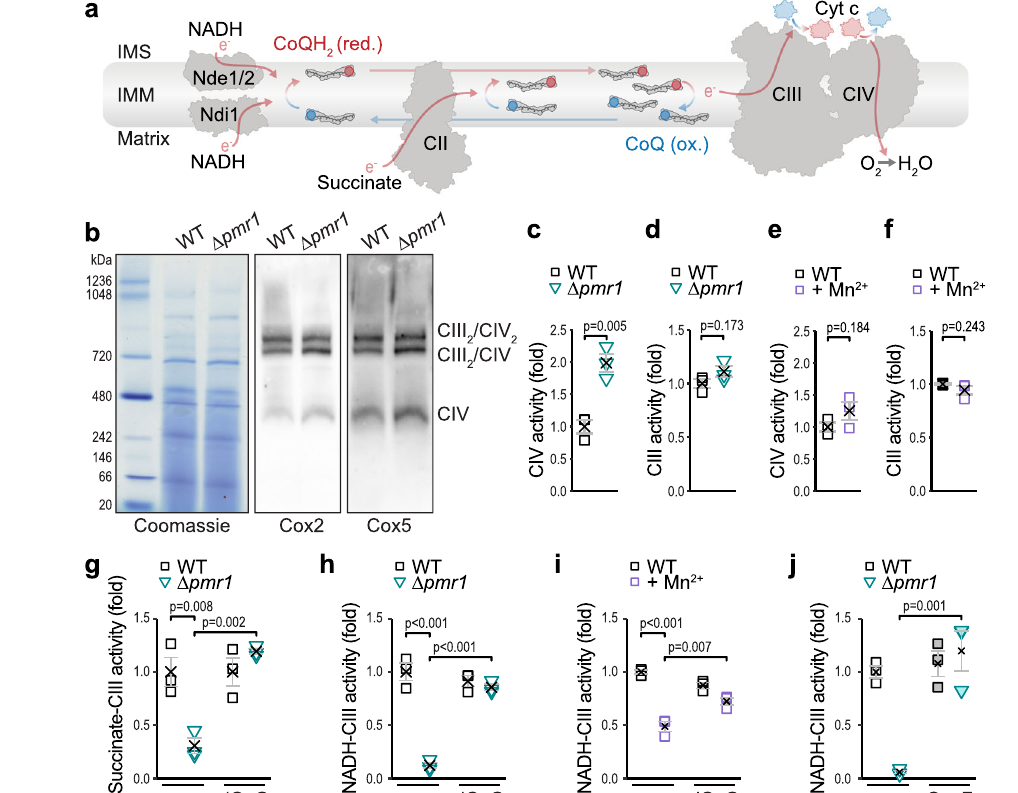
Fig.4|ExcessMndisruptsCoQ-mediatedelectrontransport,whilerespiratory chaincomplexesremainintact.a Schematicdepictingtheelectron fl owandtheQ cycle in the respiratory chain. IMS=intermembrane space; IMM=inner mito- chondrial membrane. b Blue ‐ native gel electrophoresis and immunoblots of respiratory supercomplexes in mitochondria isolated from WT and Δ pmr1 cells. Blots weredecoratedwith antibodies against CIV (Cox2and Cox5). Representative images of n =3 are shown. c – i Spectrophotometric analysis of electron fl ow through the respiratory chain in mitoplasts obtained from mitochondria isolated from the indicated conditions (WT cells with or without 5mM MnCl 2 or Δ pmr1